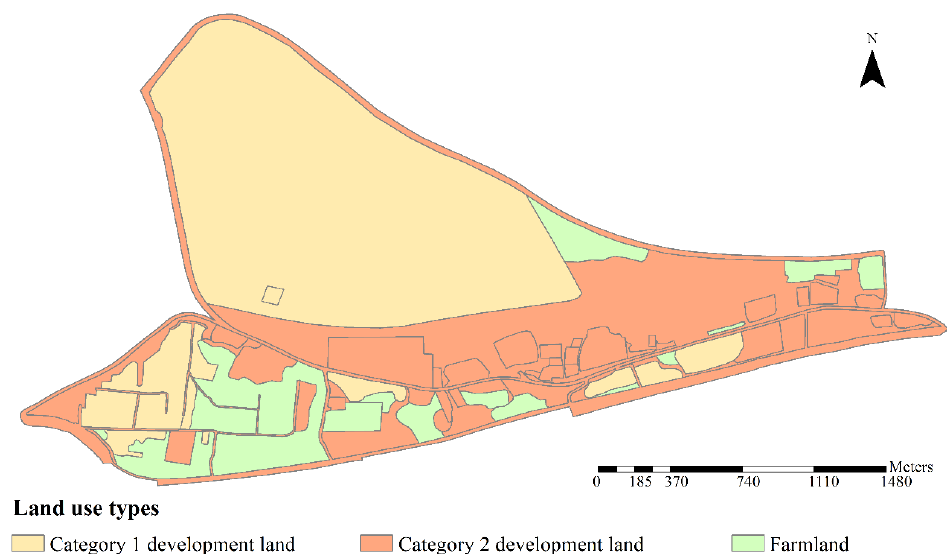
Land 2021 , 10 , x FOR PEER REVIEW Figure 4. Distribution of land types in the study area. Figure 4. Distribution of land types in the study area.